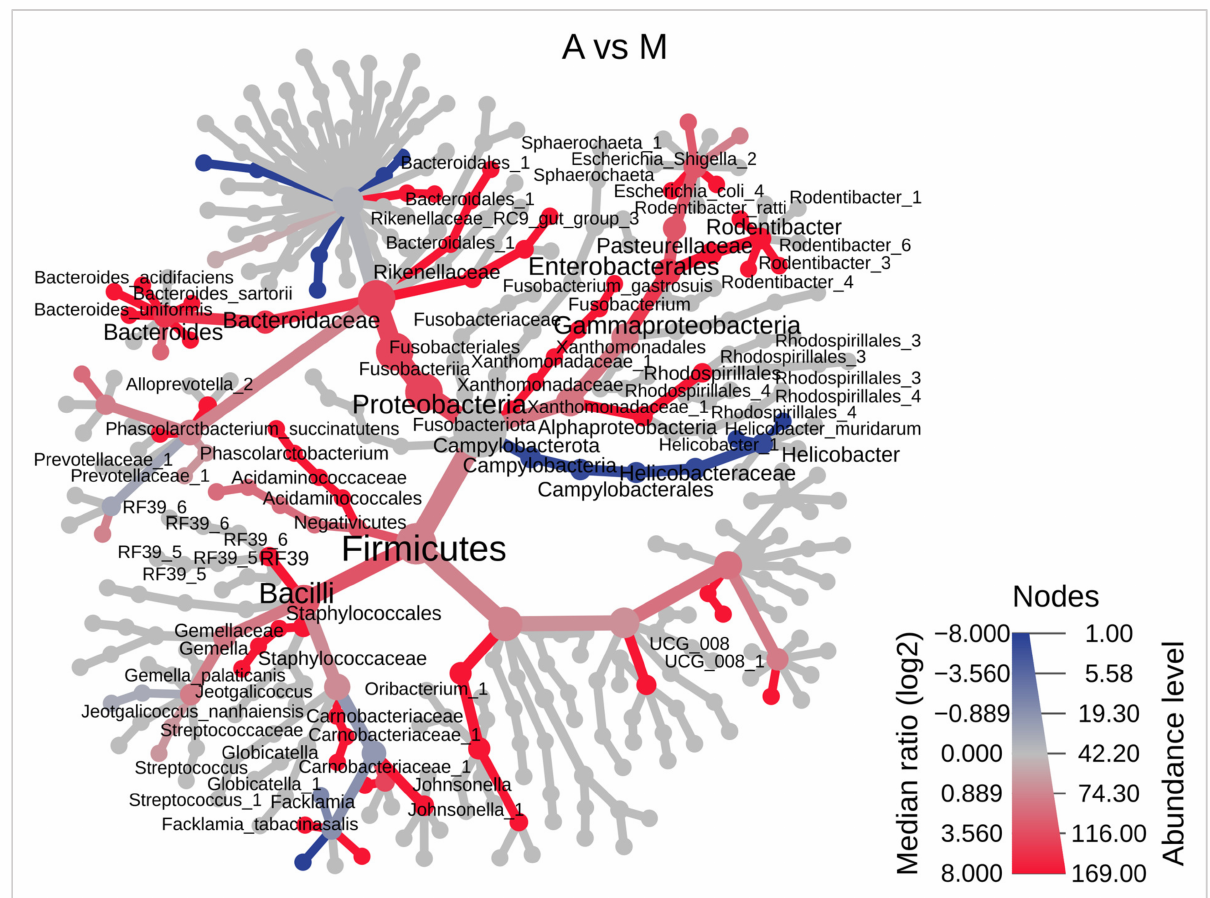
Figure 4. Taxonomic differences are visualized using a heat tree. The heat tree depicts the tax- onomic differences between the experimental anastomosis (A) and control (M) groups, up to the species level. On the heat tree, only significant taxon names are labeled. Colors indicate whether corresponding taxa are lower (blue) or higher (red) in experimental rats compared to controls. The median abundance and the statistical non-parametric Wilcoxon rank sum test ( p < 0.05) were